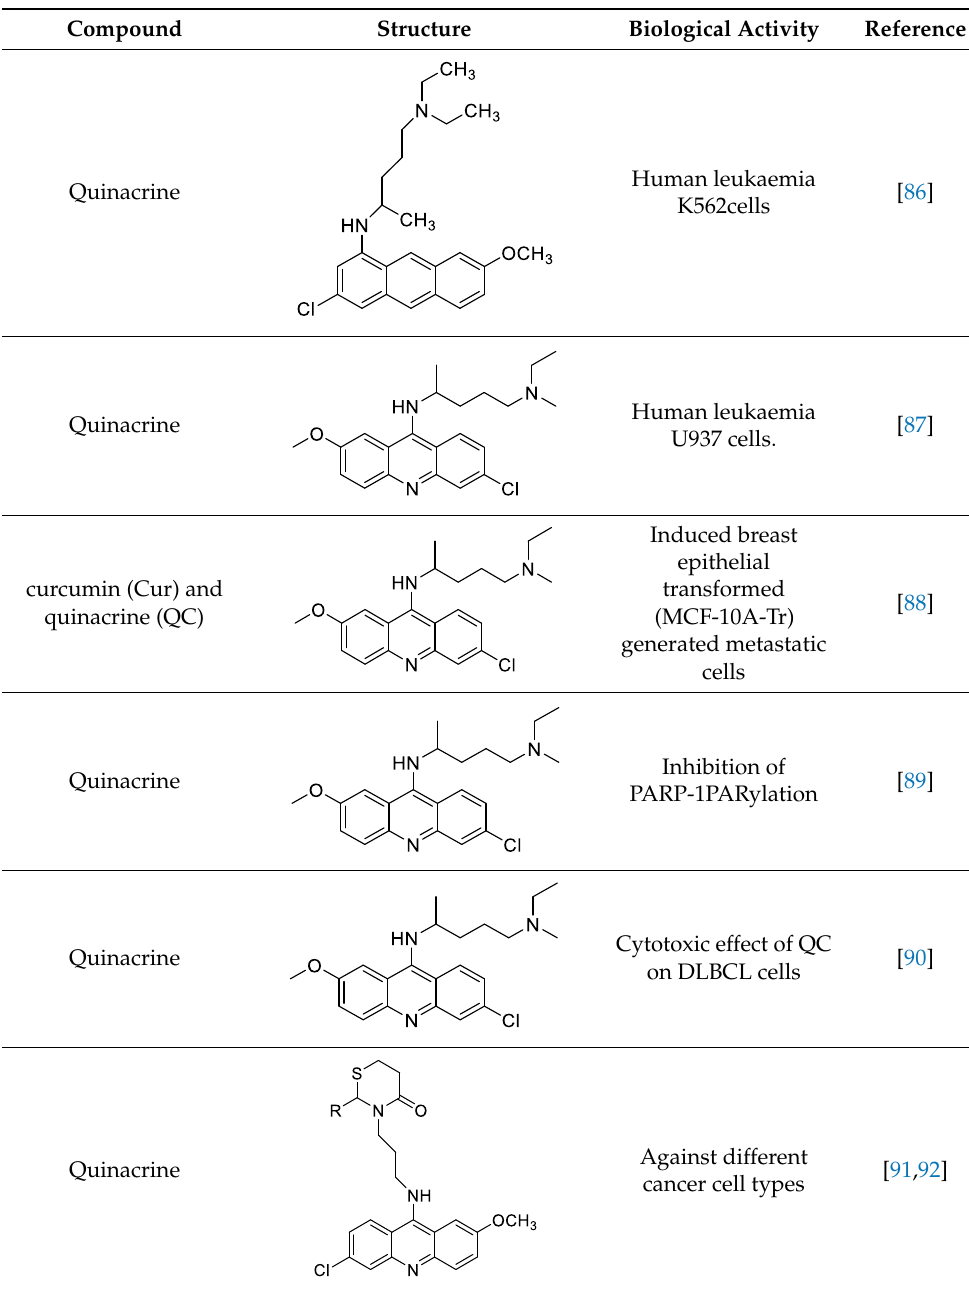
Table 13. Quinacrine as an anti-tumour